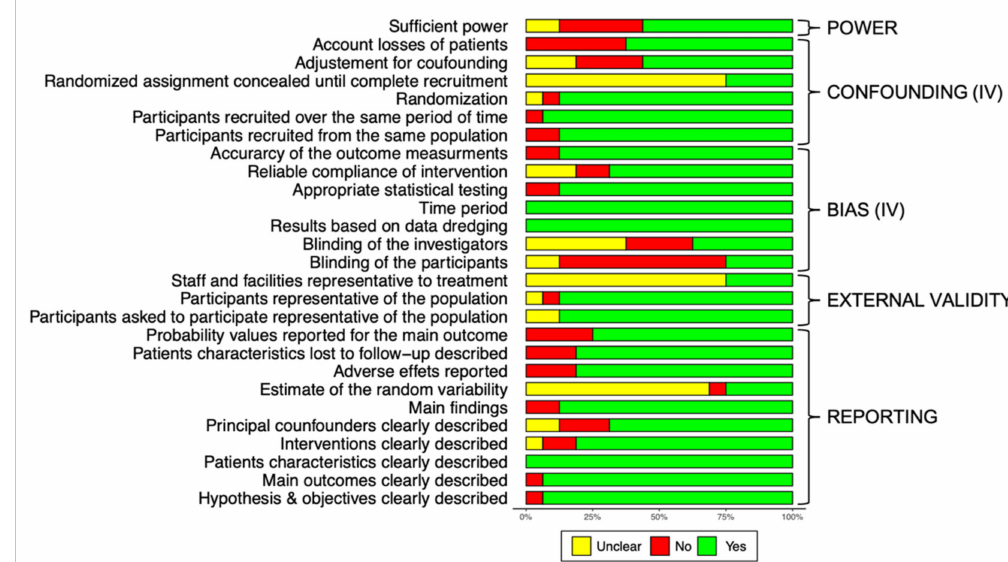
Figure 2. Quality of the study, author’s judgment broken down for each question of the Downs and Black checklist across all included studies (IV): internal validity, for the question about the data dredging the green color indicates that there is no problem and data were acquired directly and have not been